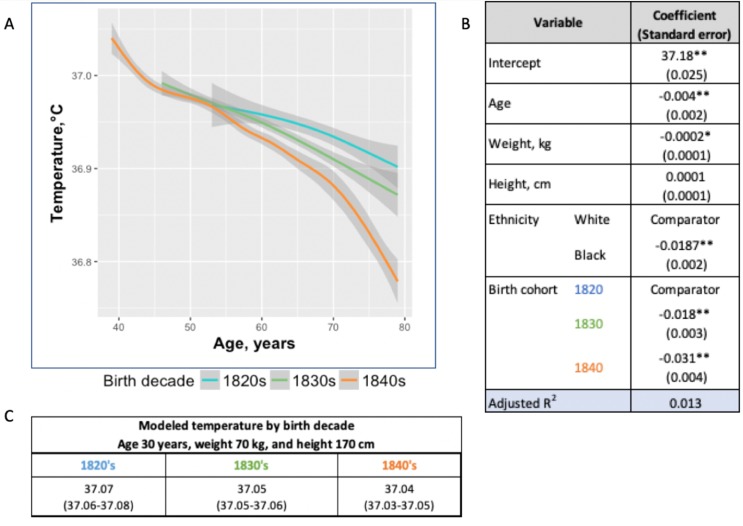
Temperature trends within birth cohorts of the UAVCW, 1860–1940 (black and white men).(A) Smoothed unadjusted data (local regression) for temperature measurement trends within birth cohorts. The different colors represent different birth cohorts (green: 1820s, blue: 1830s, orange: 1840s). (B) Coefficients (and standard errors) from multivariate linear regression including age, body weight, height and decade of birth (1820–1840) (these coefficients do not correspond to the graph as here the trajectories are approximated by linear functions). Only the three birth cohorts with more than 8000 members are included. * and ** indicate significance at the 90%, and 99% level, respectively. (C) Expected body temperature (and associated 95% confidence interval) for 30 year old men with body weight 70 kg and height 170 cm in each birth cohort. These values derive from the regression models presented in B.Figure 2—source code 1.R code for Figure 2.